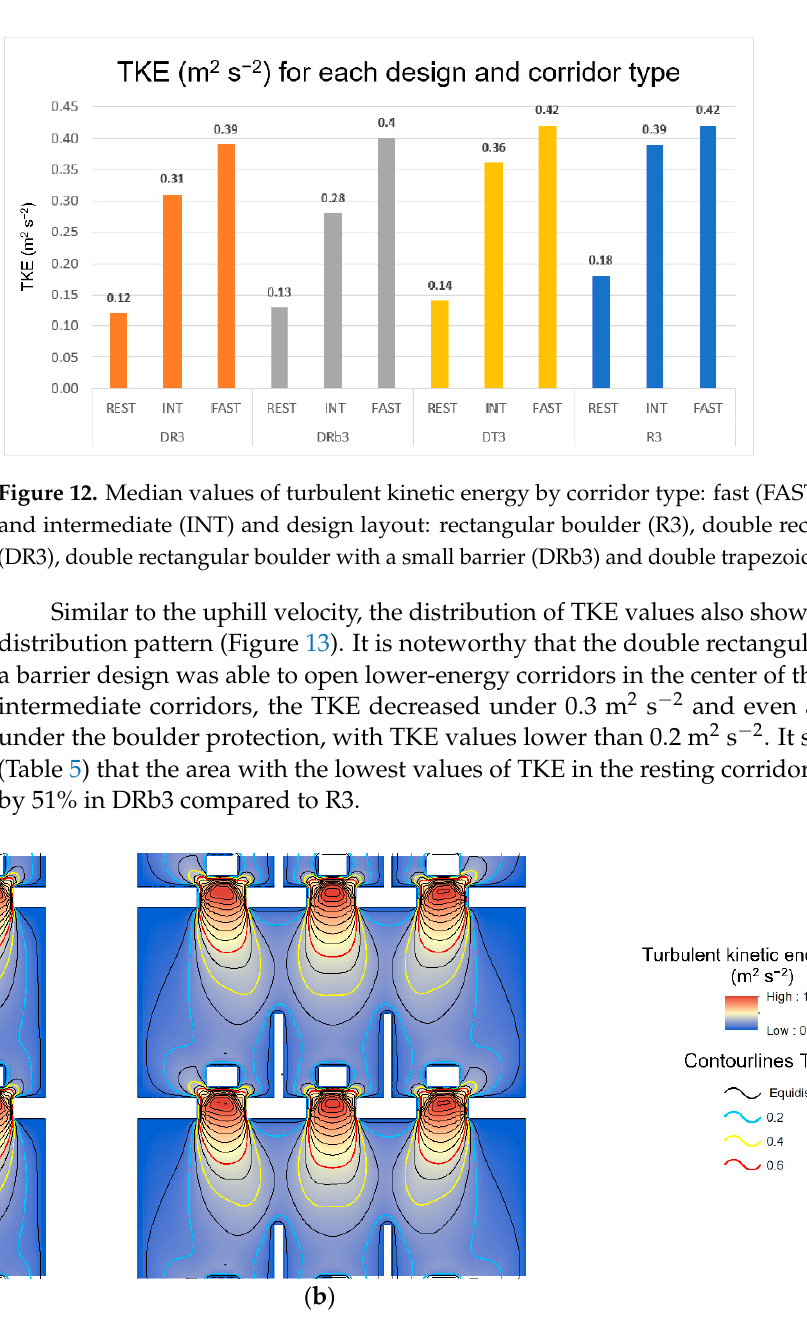
Figure 13. Turbulent kinetic energy in pool 3 and 4 for rectangular boulder layout ( a ), double rectangular boulder with a small barrier layout ( b ). Table 5. Percentage of flow area occupied by each turbulent kinetic energy range and layout type: rectangular boulder layout (R3), double rectangular boulder (DR3), double rectangular boulder with a small barrier layout (DRb3) and double trapezoidal boulders (DT3). The percentage has been calculated respect of the pool